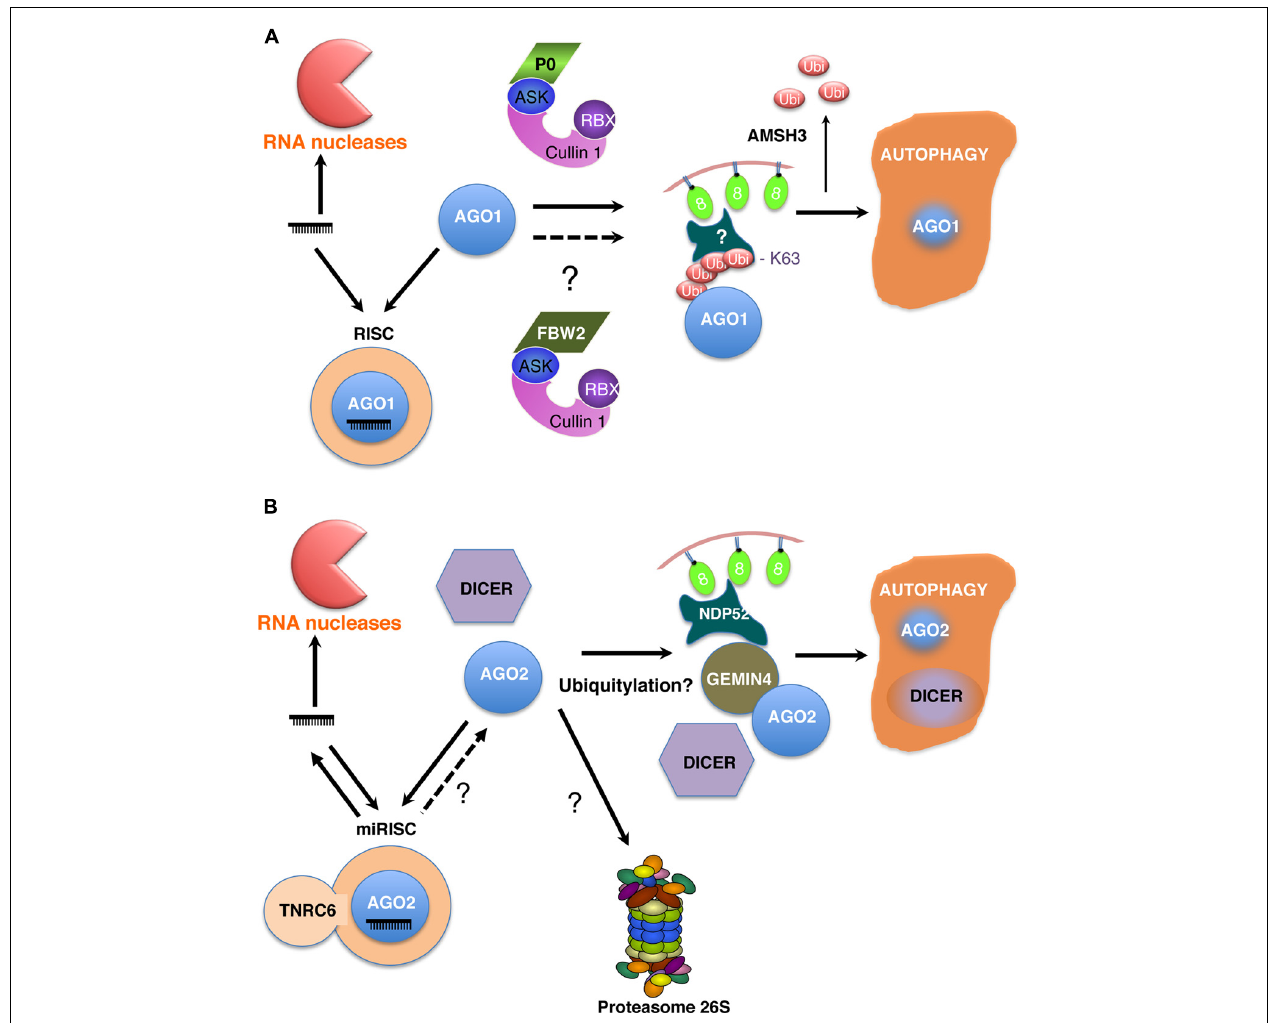
components of the silencing machinery such as DICER in mammals (B) . In Arabidopsis , the polerovirus protein P0 assembles an SCF P0 ubiquitin ligase to ubiquitylate AGO1 or an AGO1 associated protein (A) . Viral P0-mediated AGO1 degradation by autophagy also requires the deubiquitylating enzyme AMSH3. However, the identity of endogenous ubiquitin ligases involved in this process have not yet been unambiguously identified.The role of ubiquitylation in the turnover of human AGO2 is at present unclear but requires GEMIN4 and NDP52 (B) . Finally, whether upon guide RNA dissociation AGO2 would become accessible to autophagy and the role of the proteasome in AGOs degradation are other still open